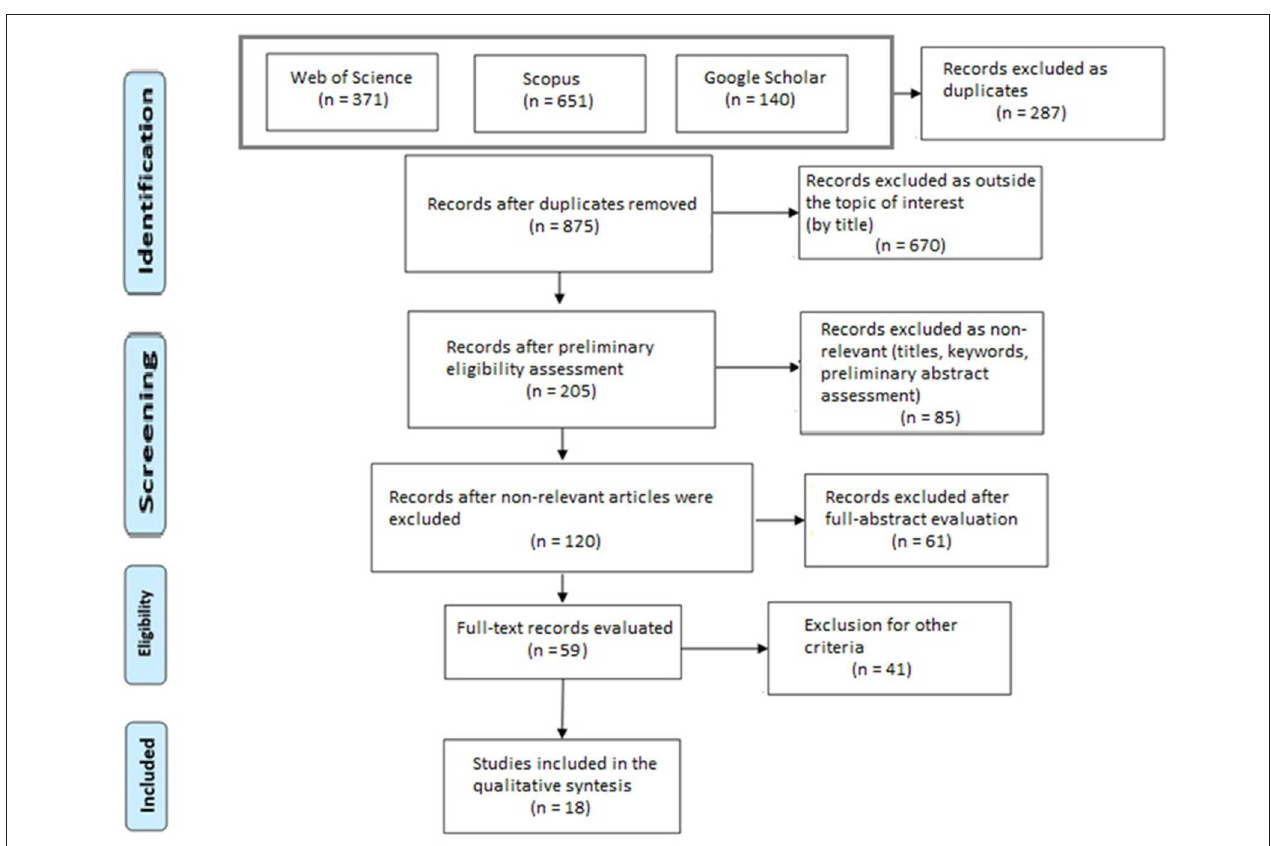
FIGURE 1 | PRISMA flow diagram showing the various stages of article